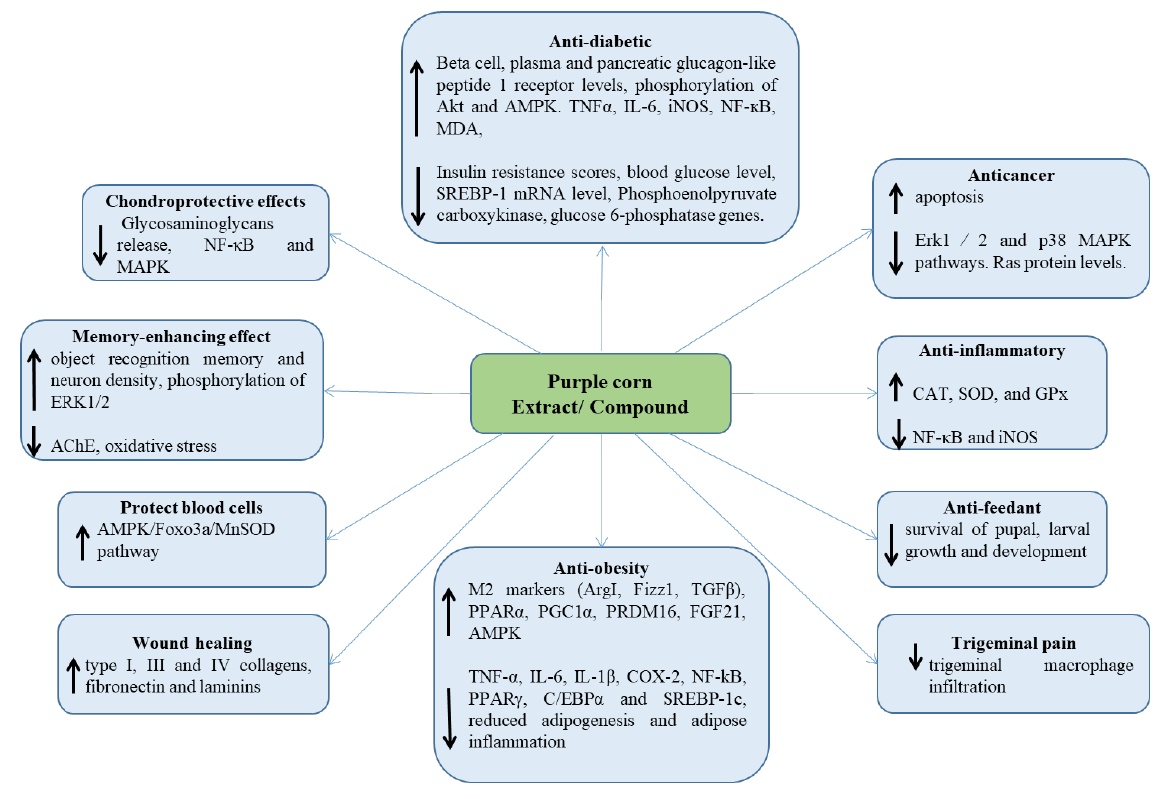
Figure 4. In vivo biological activities and mechanisms of purple corn. Table 2. In vivo biological properties of extracts and compounds from purple corn.